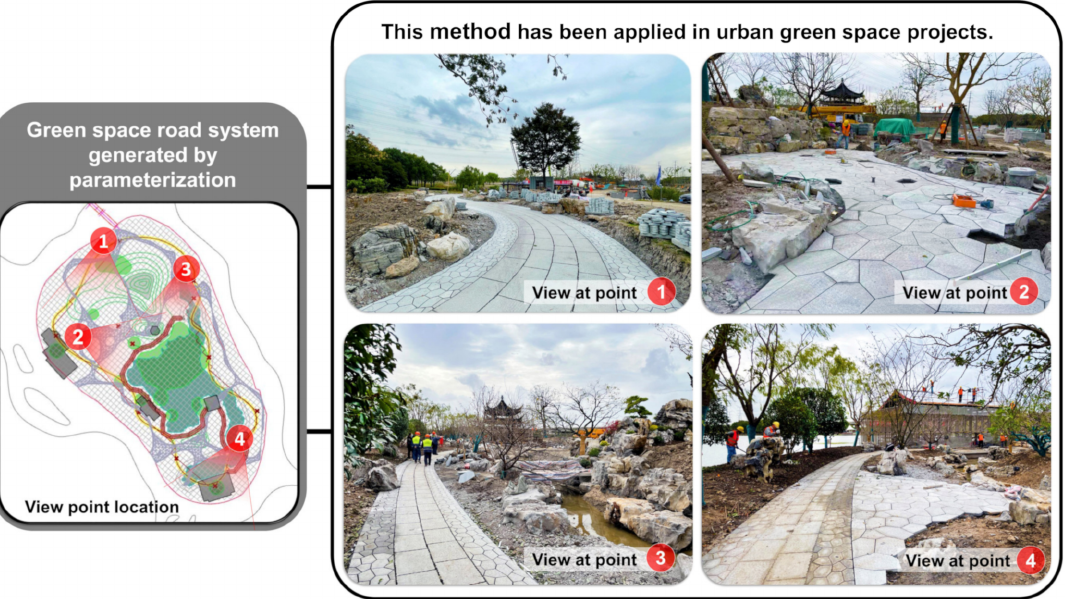
Figure 20. Application of intelligent road generation in urban green space. (Image source: pho- tographed and annotated by the